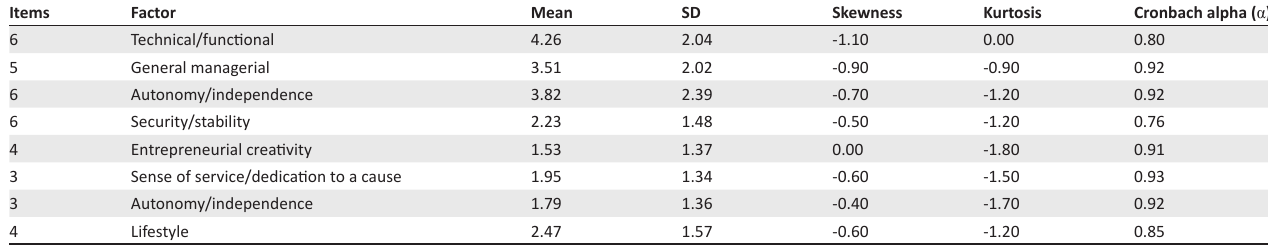
TABLE 3: Descriptive statistics and Cronbach alpha coefficient of the career anchors.